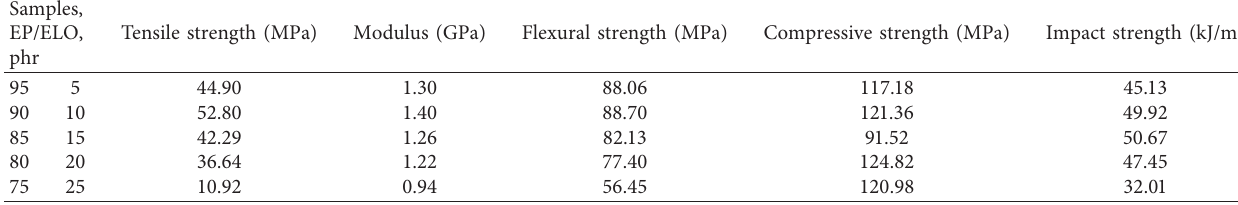
Table 2: Effects of epoxidized linseed oil on the mechanical strength of blend materials. Samples, EP/ELO,